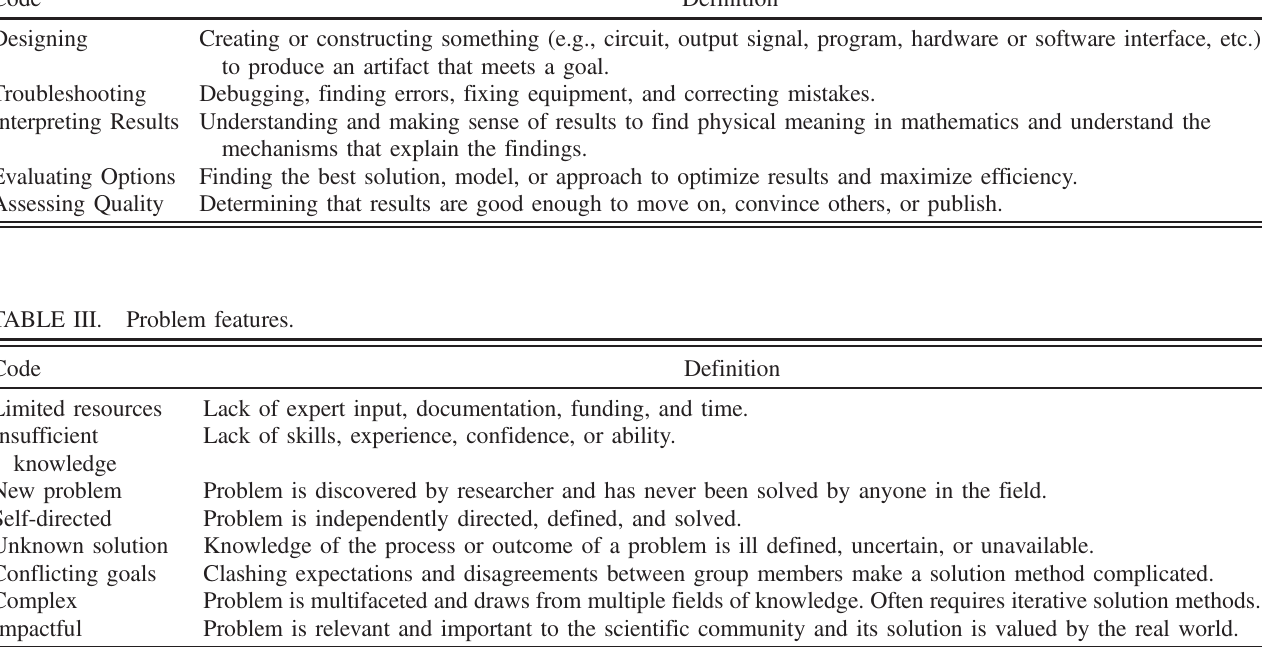
TABLE II. Problem activities. Code Definition